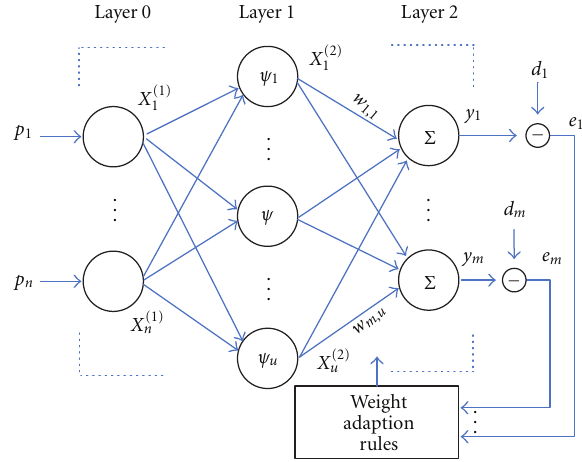
Figure 1: MIMO radial basis function network